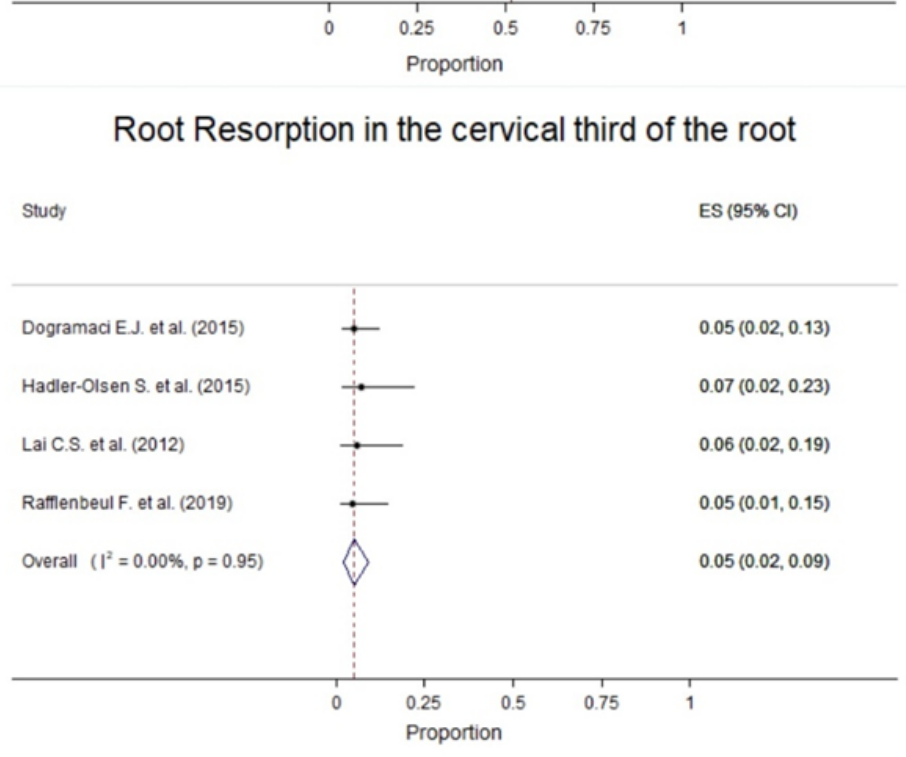
Figure 3. Forest plots with the prevalence of root resorption for patients with impacted canines by location [26–32].